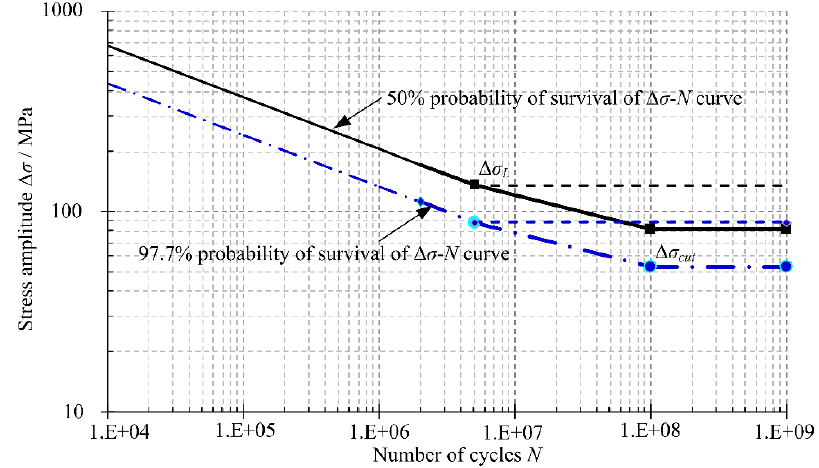
Figure 13. The extended Δ σ - N curves.